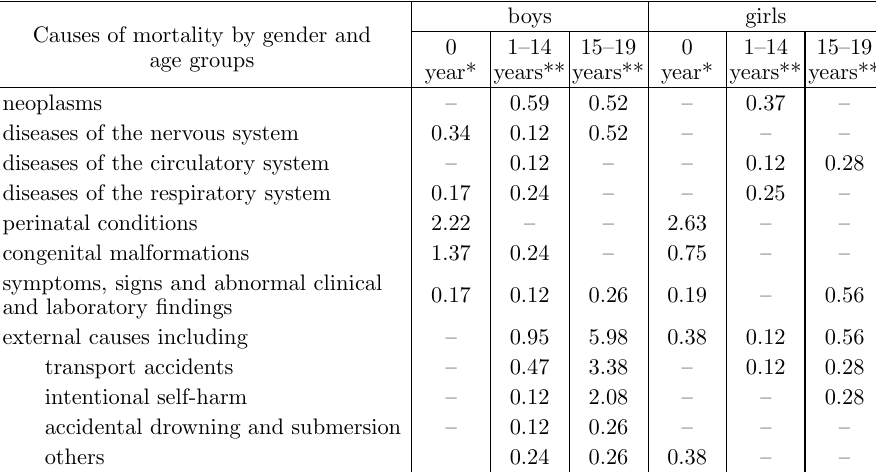
Table 4. Mortality rates in the age group of 0–19 years, grouped according to sex and causes in the year 2012 in the Podlaskie